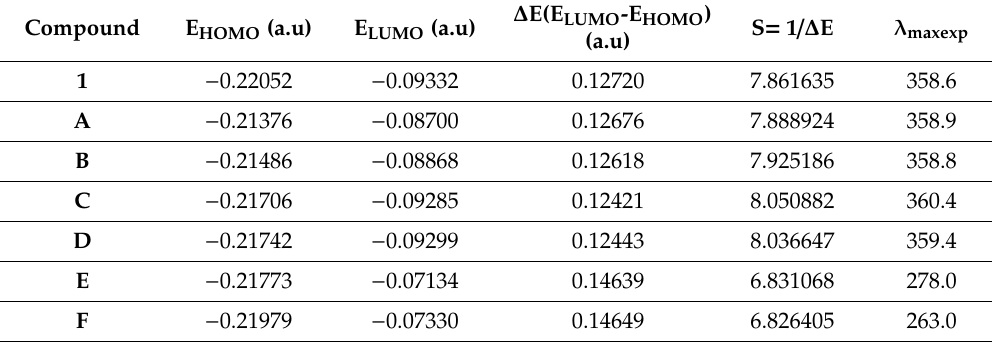
Table 4. Molecular orbital energies, hardness ( η ), and global softness ( S ) of compounds A – F . Compound E HOMO